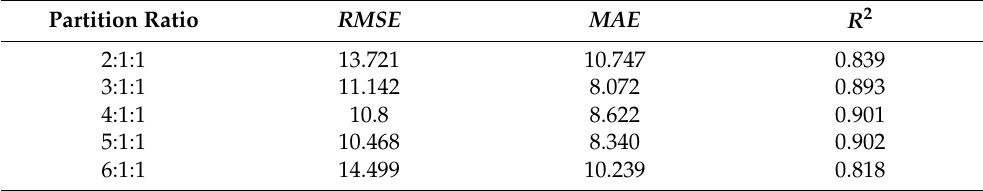
Table 2. The influence of different partition ratios on prediction